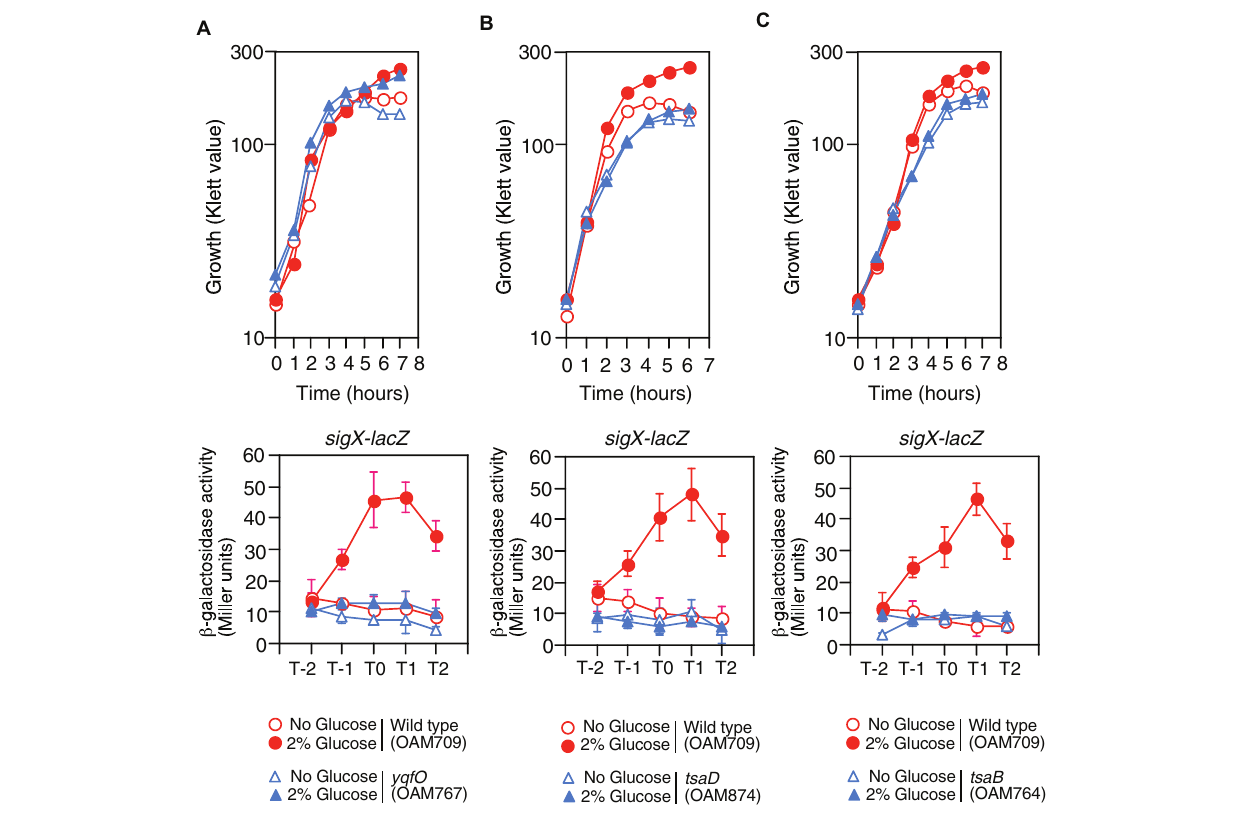
FIGURE 2 | Growth and expression of sigX-lacZ in the mutants. (A) yqfO . (B) tsaD . (C) tsaB . The relevant genotypes are indicated below the panel. Growth curves of the wild-type and each mutant strain monitored by Klett colorimeter are shown (upper panel). Means of the β -Gal activities from three independent experiments and the standard deviations are shown (lower panel). The x axis is the same as in the legend to Figure 1